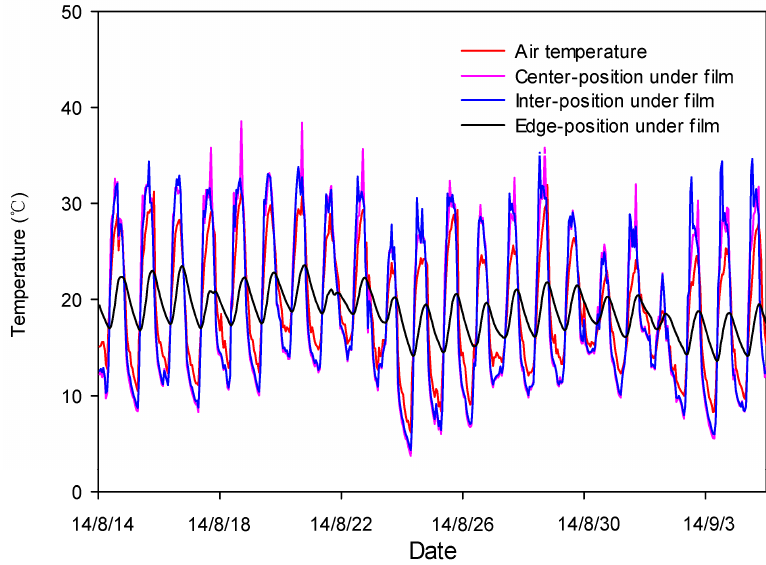
Figure 7. Daily changes of temperature in different positions under film, with the air temperature as a reference. Center ‐ position under film (horizontal distance from the dripper is 0 cm), inter ‐ position under film (horizontal distance from the dripper is 20 cm), edge ‐ position under film (horizontal distance from the dripper is 50 cm).